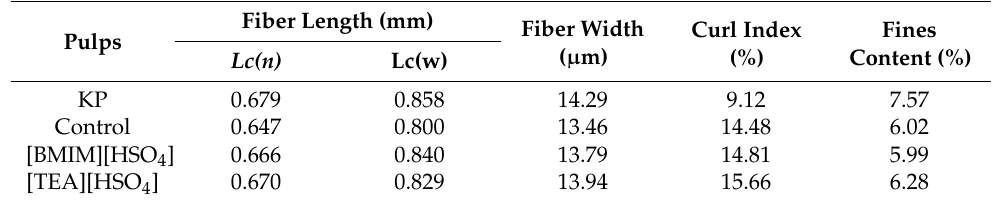
Table 3. The effect of ILs pretreatment on the fiber qualities of eucalyptus kraft pulps during the oxygen delignification process.